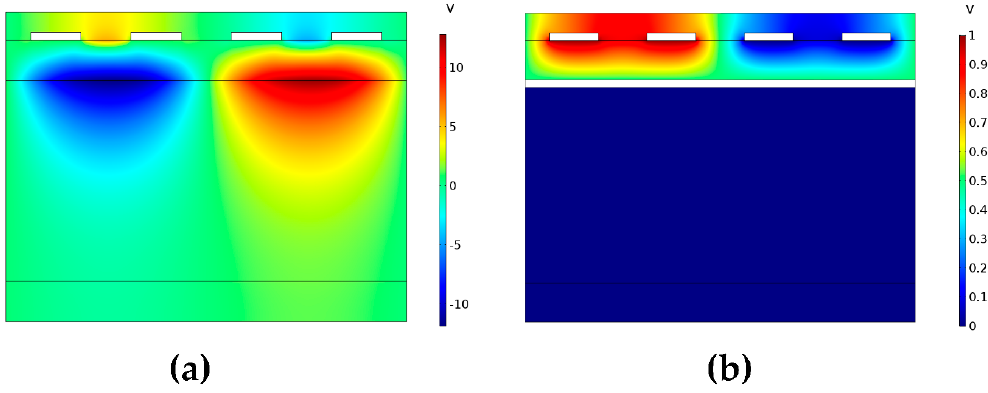
Figure 2. ( a ) The simulated electric field distribution of acoustic wave resonator without bottom metal Moly layer, ( b ) the simulated electric field distribution of acoustic wave resonator with bottom metal Moly layer.